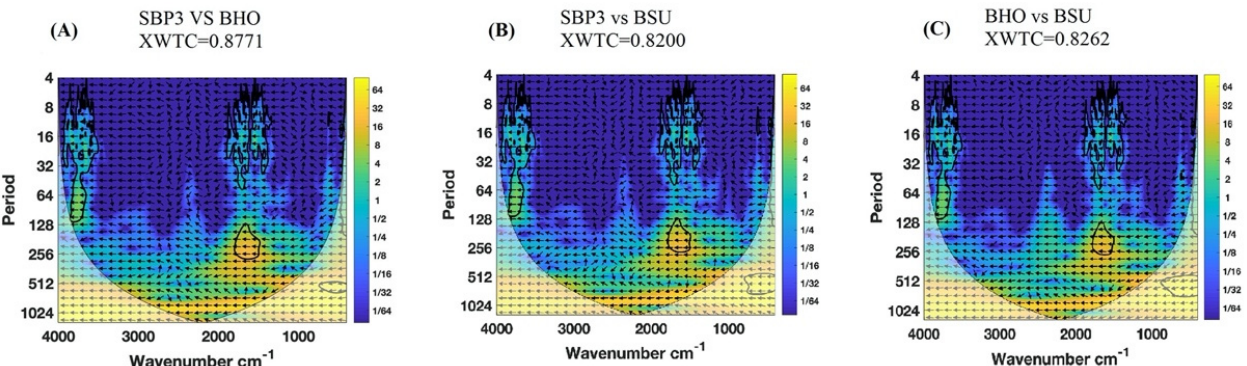
Figure 3. Comparison among FTIR spectra using the coefficient of the wavelet correlation between spores: ( A ) B. subtilis (BSU) 168 vs. B. horneckiae SBP3(SBP3); ( B ) B. horneckiae DSM 23495 T (BHO) vs. B. horneckiae SBP3; and ( C ) B. subtilis 168 (BSU) vs. B. horneckiae DSM 23495 T (BHO).